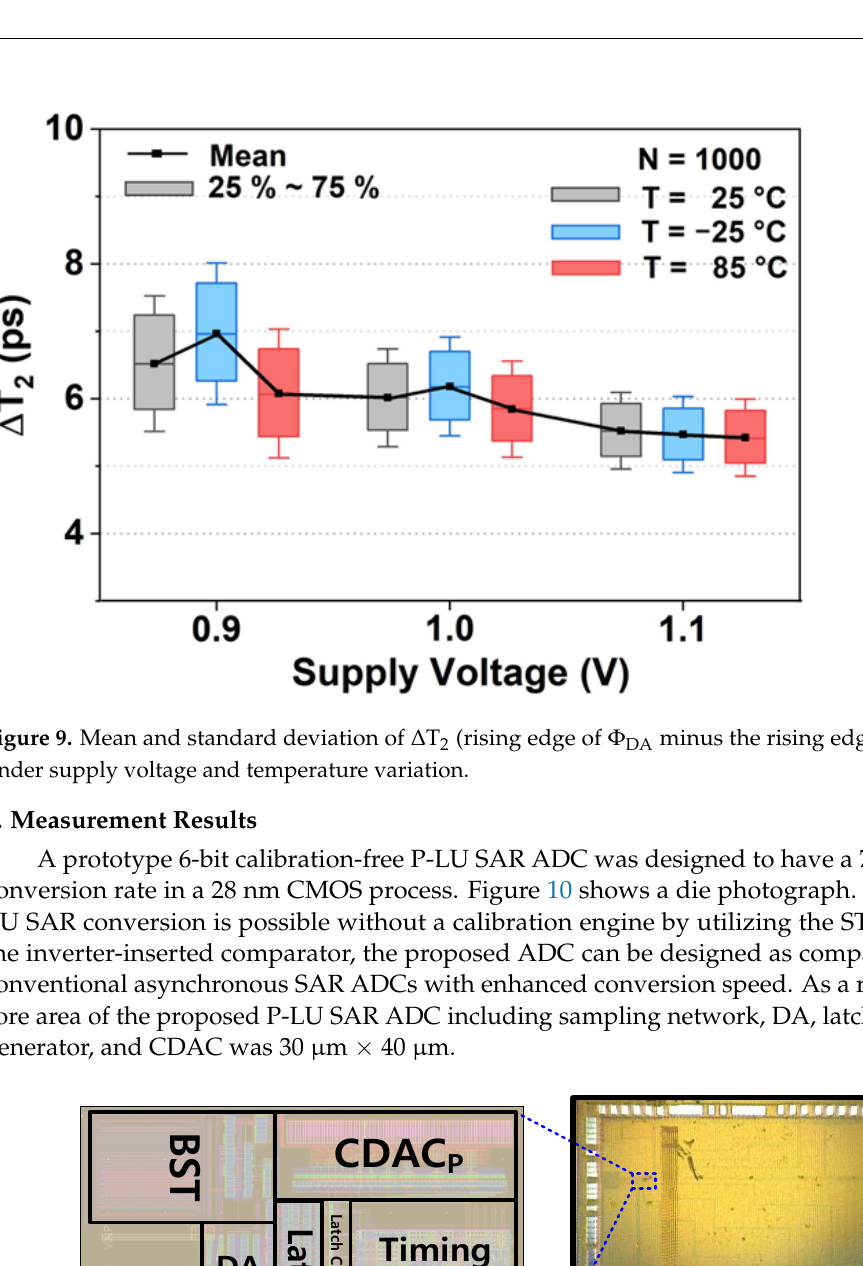
Figure 11. Measured DNL and INL. The measured signal-to-noise and distortion ratio (SNDR) and spurious-free dy- namic range (SFDR) results of five samples with a 349.74 MHz input at a 700 MS/s are shown in Figure 12. The SNDR and SFDR for the five samples were above 34 dB and 47 dB, respectively. Although the number of measurement samples was rather limited, these measurement results indirectly showed that the proposed ADC could achieve good per- formance without an offset calibration.